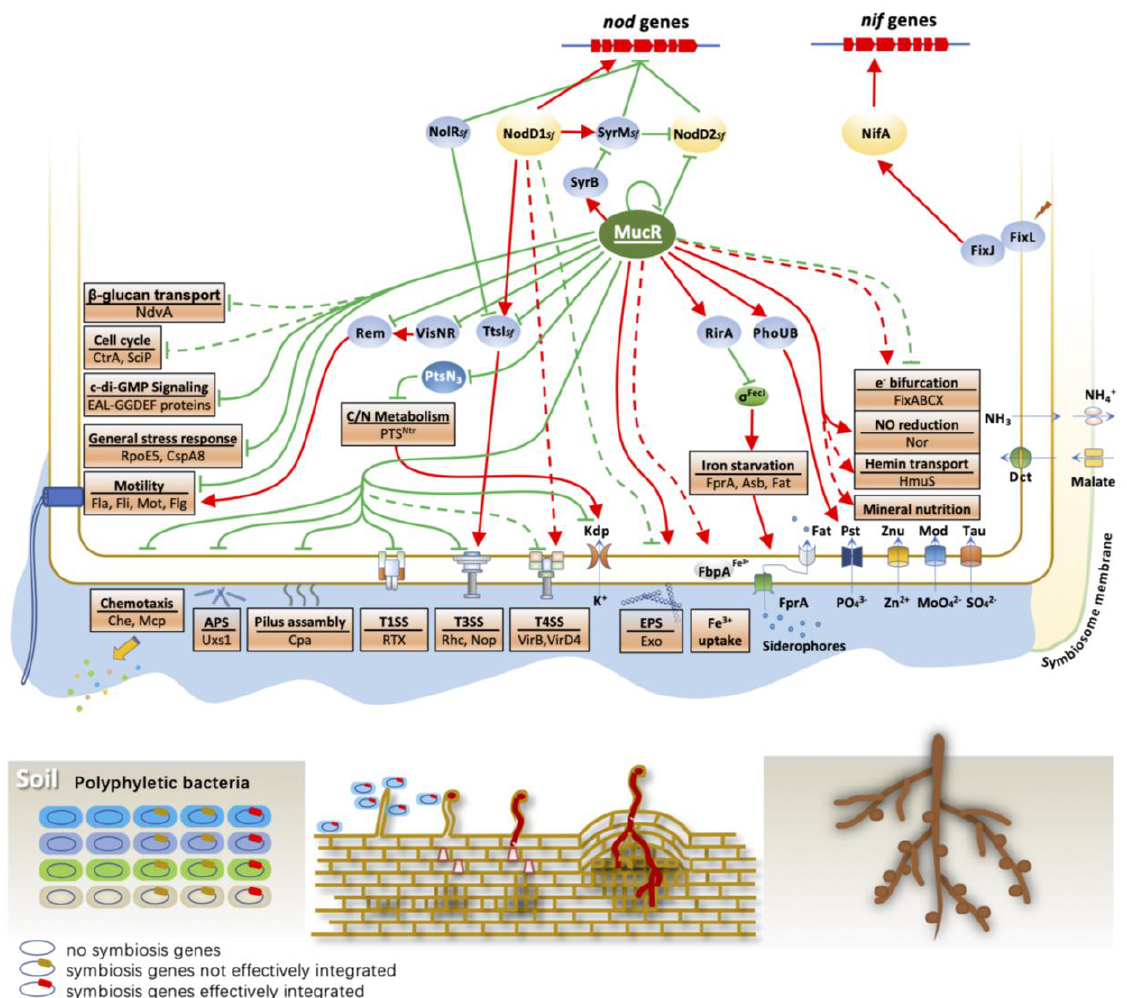
Figure 3. Working model for transcriptional integration of key symbiosis genes. Red arrow, positive regulation; green line, negative regulation. Solid lines indicate cases with molecular evidence. EPS, exopolysaccharide; APS, arabinose-containing polysaccharide; NO, nitric oxide. Sf , S. fredii ; Sm , S. meliloti . For simplicity, functional genes in broad-host-range S. fredii are shown. The negative regulation of syrM by SyrB and positive regulation of nifA by FixJ are demonstrated in S. meliloti .